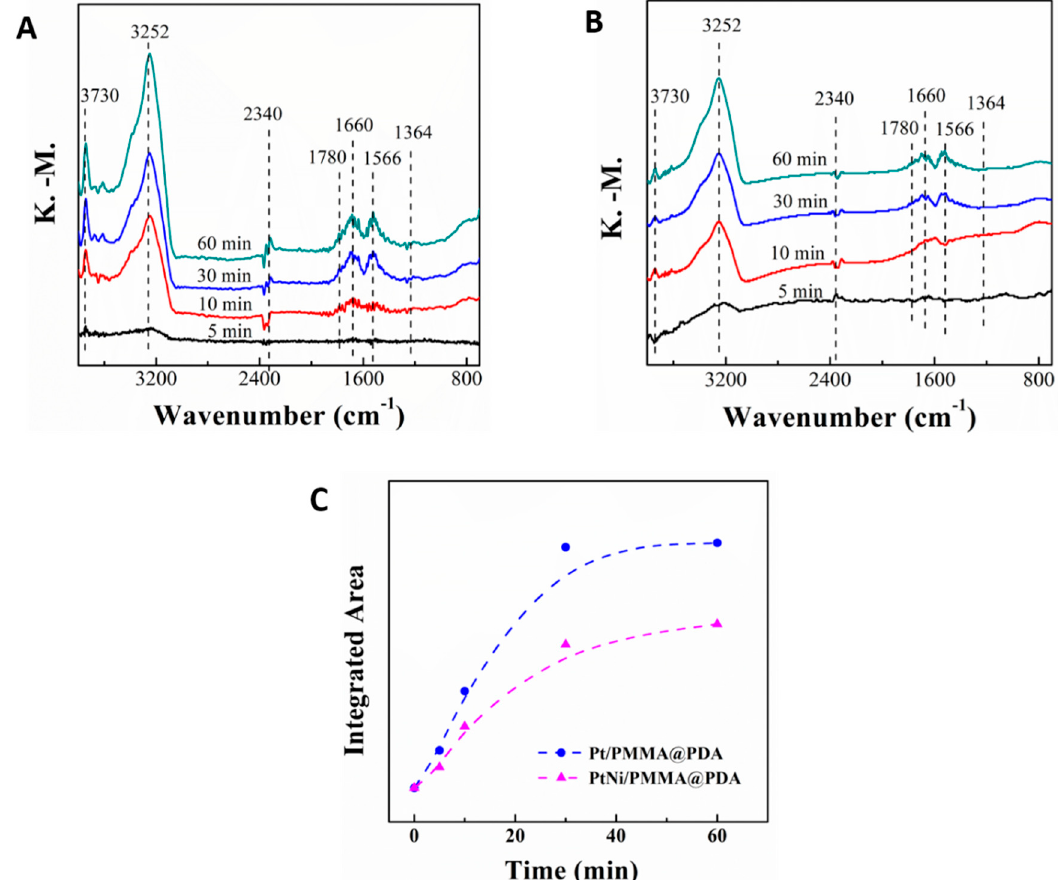
Figure 7. In situ diffuse reflectance infrared Fourier transform spectroscopy (DRIFTS) spectra of gas mixture (O 2 + He + HCHO) adsorption at 25 ℃ of Pt/PMMA@PDA ( A ) and